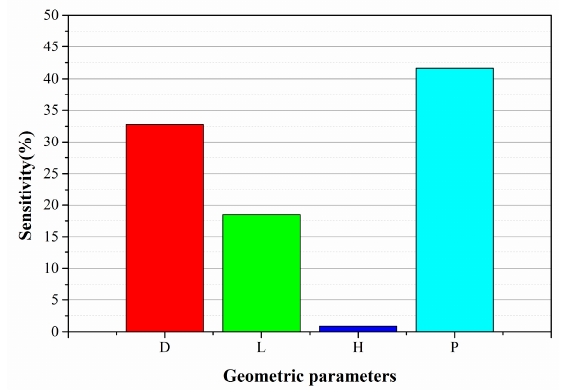
Figure 14. Sensitivity comparison of Δ C m with different geometric parameters ( Ma = 0.75, α = 0°).